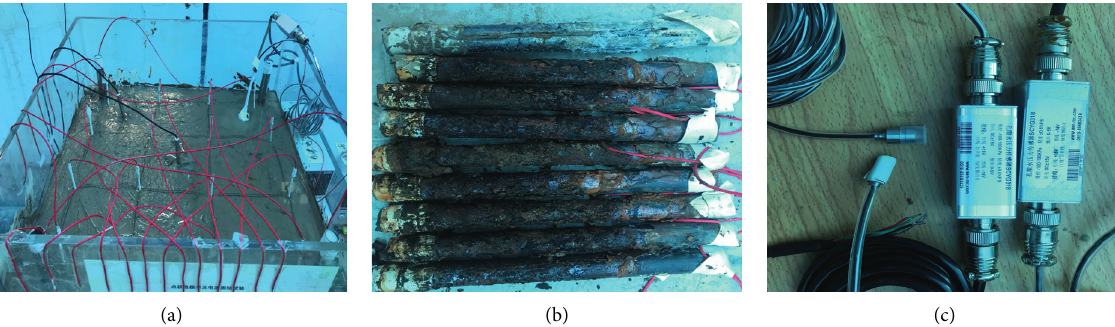
Figure 2: Electroosmotic consolidation model test. (a) Electroosmosis model box. (b) Metal electrodes. (c) Micropore water pressure sensors.